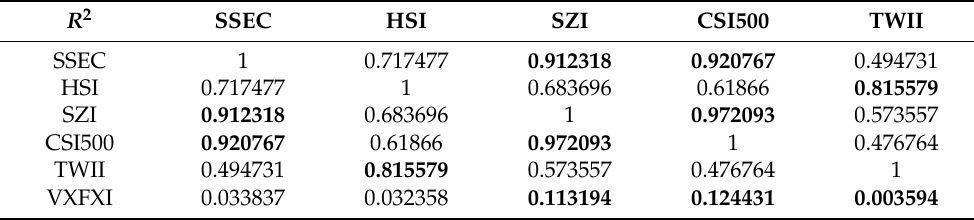
Table 5. Stock market index and its related major evens.